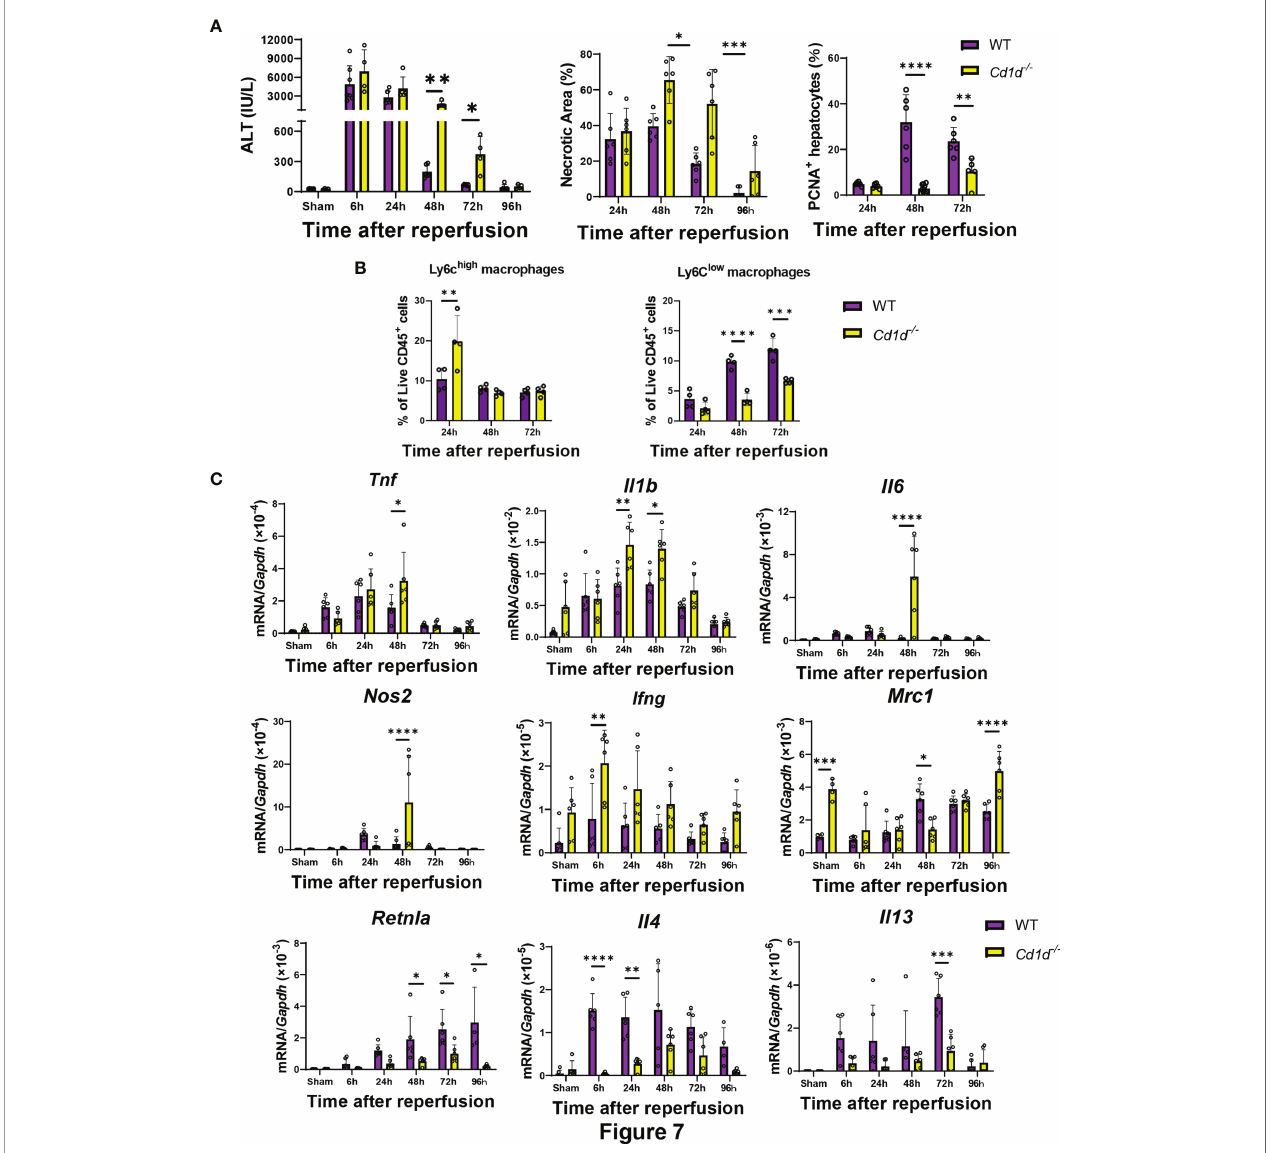
FIGURE 7 | Cd1d -/- mice exhibited delayed liver repair and macrophage differentiation during hepatic I/R injury. (A) ALT levels, hepatic necrosis, and PCNA + - hepatocytes (%), (B) the percentage of Ly6C high macrophages (Ly6G - /Ly6C high /CD11b high /F4/80 high cells) and Ly6C low macrophages (Ly6G - /Ly6C low /CD11b high /F4/ 80 high cells), and (C) expression of genes related to pro-in fl ammatory ( Tnf, Il1b, Il6, Nos2, and Ifng ) and reparative macrophages phenotypes ( Mrc1, Retnla, Il4, and Il13 ) after hepatic I/R injury in WT and Cd1d -/- mice. Data are expressed as the mean ± SD (six biological replicates per group). * P < 0.05, ** P < 0.01, *** P < 0.001, **** P <